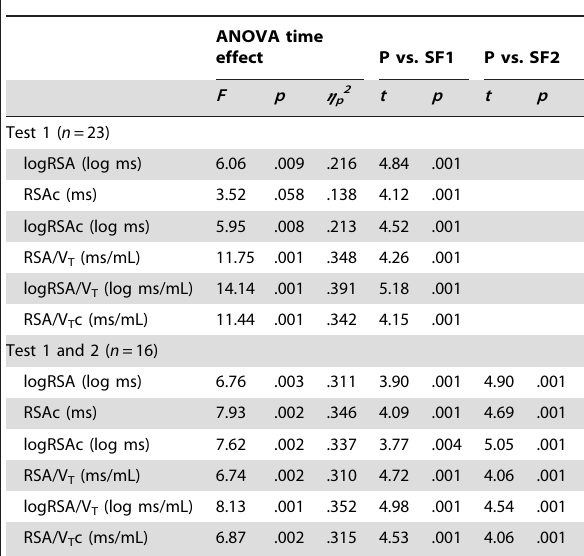
Table 5. ANOVA time effects ( df =4,60 or 2,44) and paired t - tests ( df =15 or 22) measuring reduction in additional respiration-uncorrected and corrected RSA indices during Still-Face Test 1 and